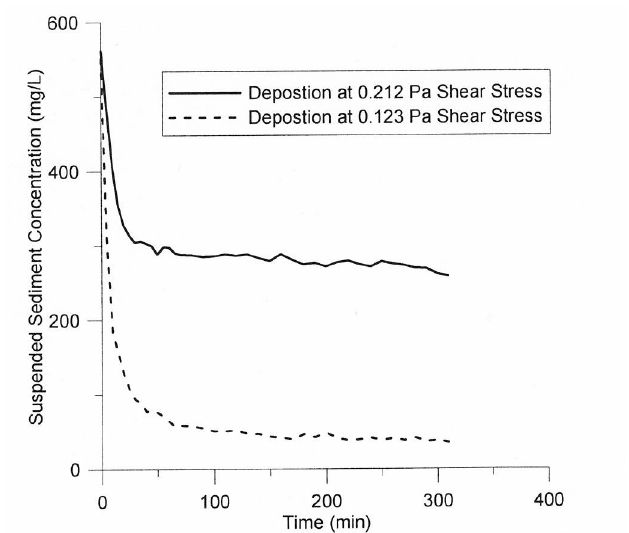
Fig. 1 Deposition of cohesive sediment for two bed shear stress conditions (0.123 Pa and 0.212